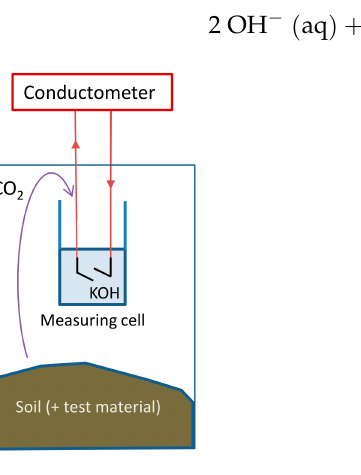
Figure 2. Measuring unit of the parallel